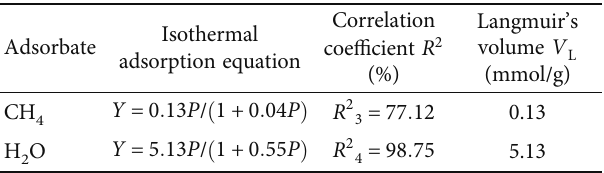
Table 7: Fitting data of di ff erent adsorbates with Langmuir under